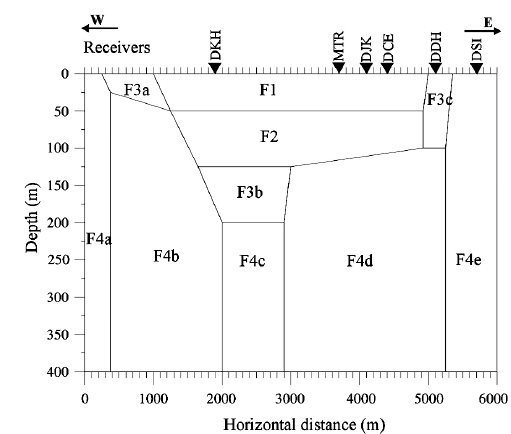
Fig. 6. Final model adjusted for the application of 2D finite-difference modeling. The model is drawn on E-W direction near the B-B ′ cross-section shown in fig. 2. Observation stations projected on the cross- section are shown with triangles. The physical pa- rameters for each block are given in table